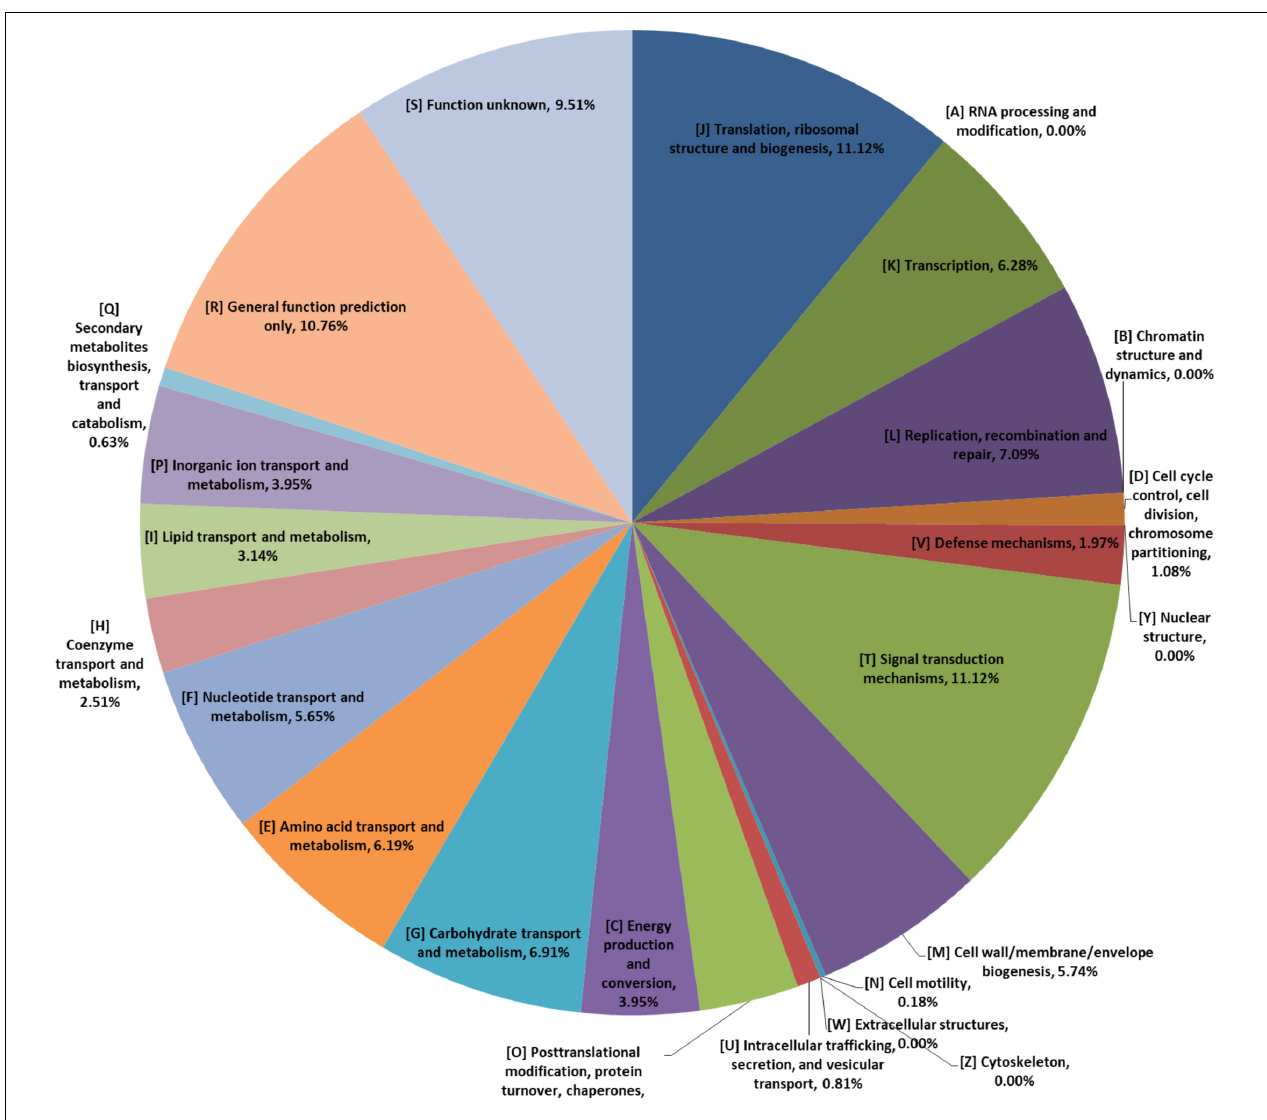
FIGURE 2 | The COG annotation of core-genomes of P.